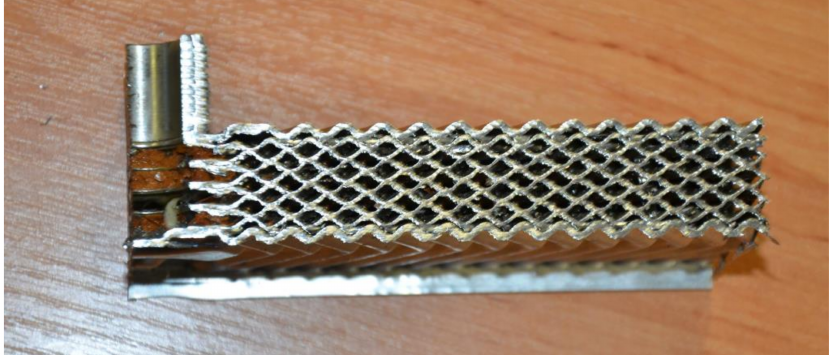
Figure 10. HEX-1 cross-section view. The inlet is clogged with loose incrustations from the pipe upstream of the exchanger. The heat exchange surface itself is minimally clogged.